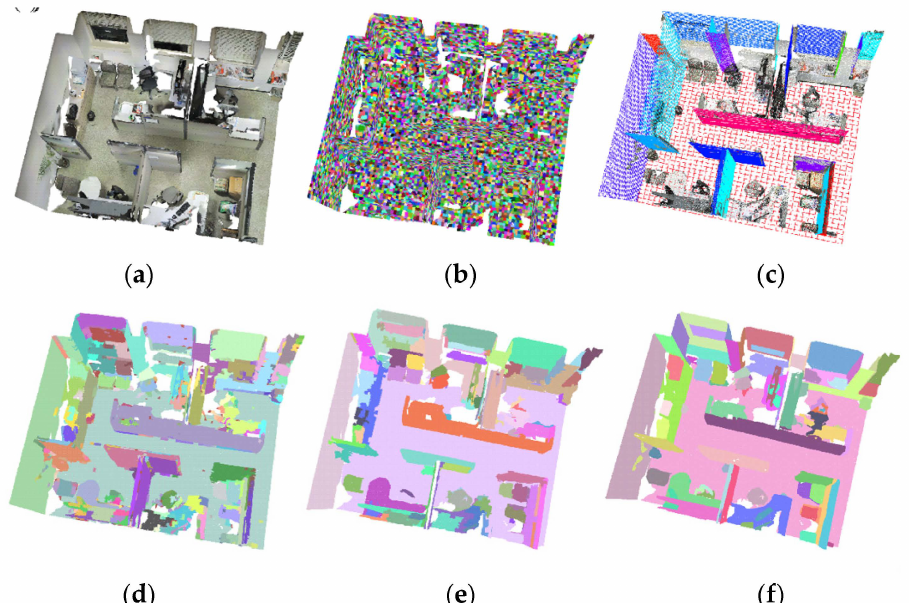
Figure 5. The segmentation result of office-1. ( a ) Raw point clouds ( b ) The generated surface patches. ( c ) The extracted indoor structural planes set and leftover points of the scene. ( d ) The indoor seg- mentations after multi-constraint graph clustering. ( e ) The final segmentation result after post-re- finement. ( f ) The ground truth.